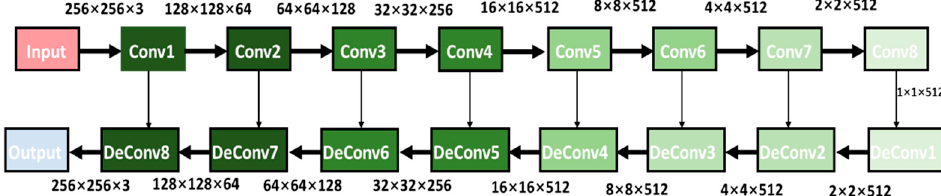
Figure 3. Underwater image enhancement network generator. The generator used a system with an encoder and decoder, a reference for the design of the network model for the U-Net network, and a network for the convolutional neural network; the input and output were the three RGB channels.